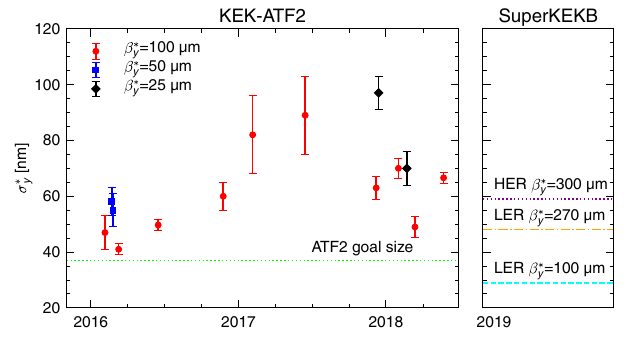
FIG. 1. Measured vertical beam sizes in ATF2 [17] for different values of β (cid:1) x and β (cid:1) y as compared to the nominal value. On the left are the nominal vertical beam sizes intended for SuperKEKB rings HER and LER. An additional line is added for the case of reduced β (cid:1) y in